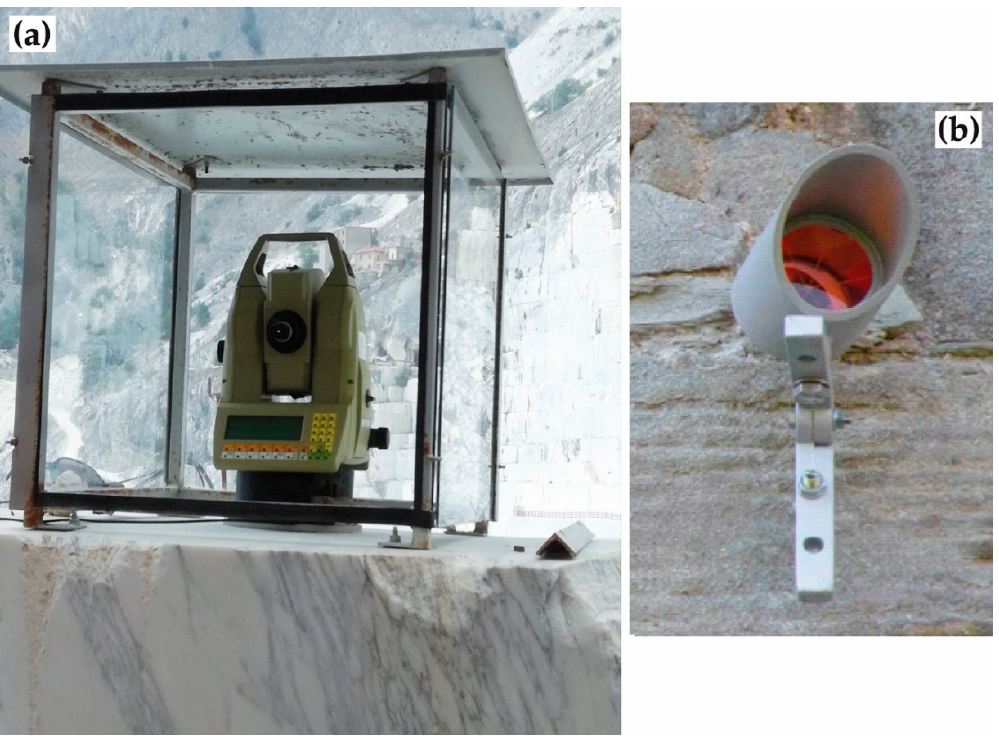
Figure 3. ( a ) RTS installed at the Lorano marble quarry. ( b ) Detail of a prism placed on the excavation site walls.